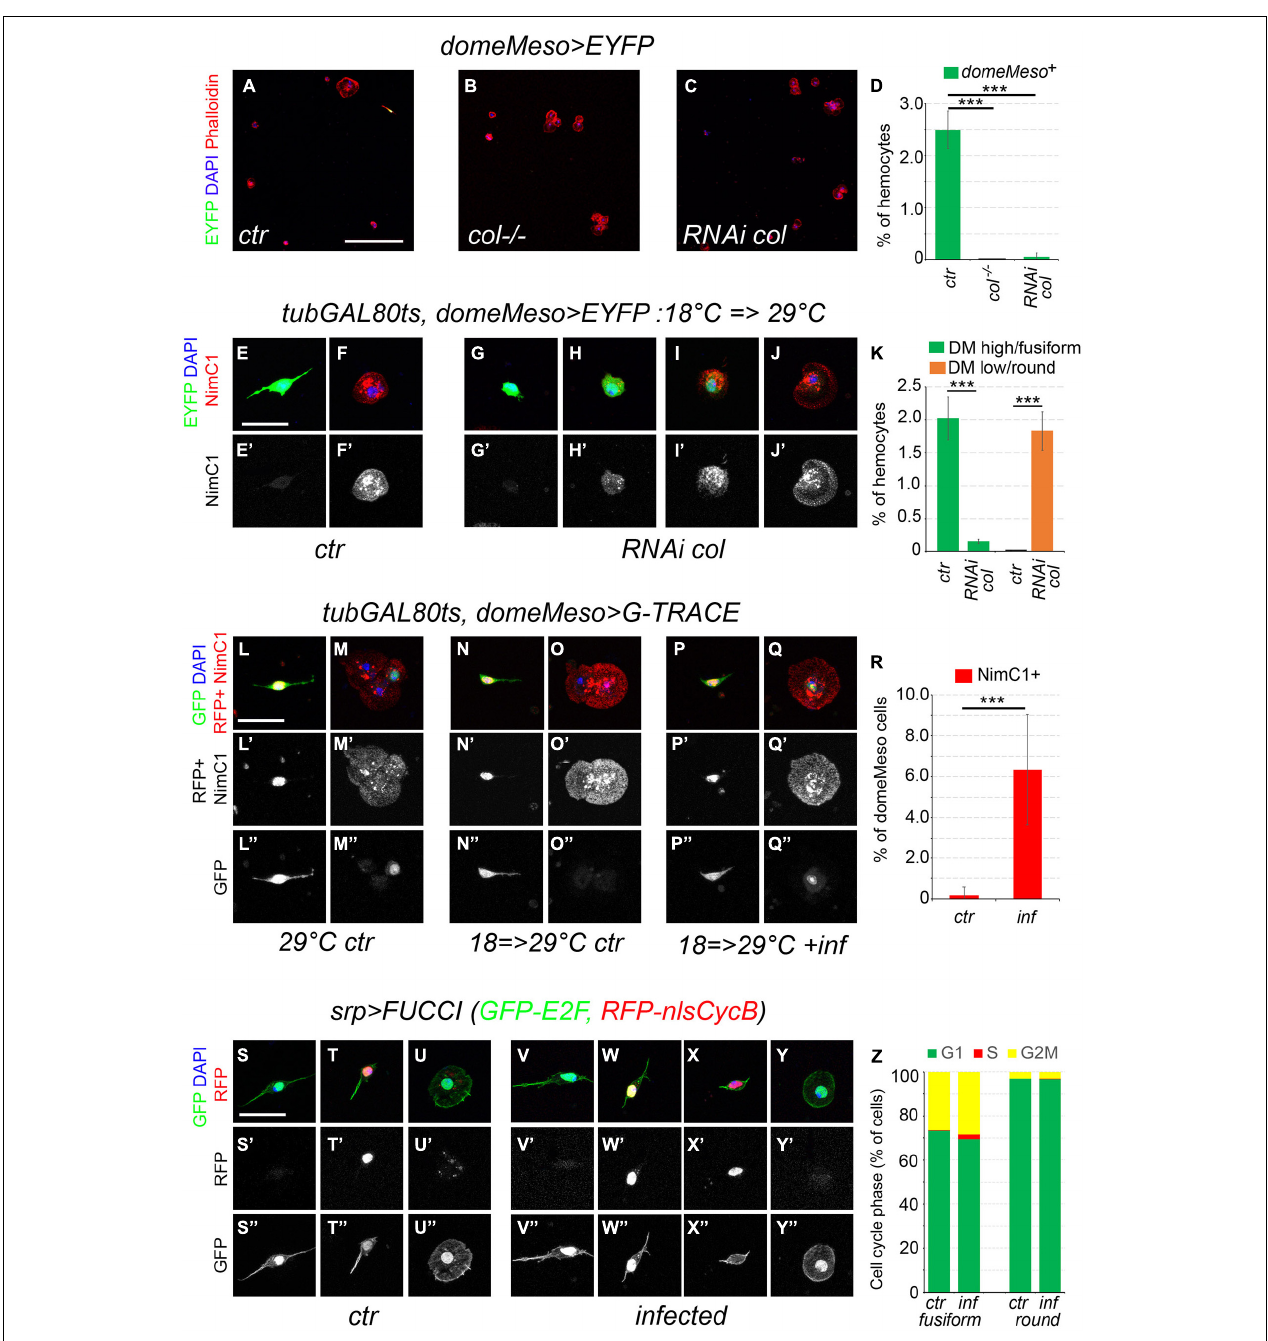
FIGURE 7 | Fusiform cells can differentiate and proliferate. (A–C) Confocal views of blood cells from domeMeso-GAL4, UAS-2xEYFP ( A , ctr ), col − / − , domeMeso-GAL4, UAS-2xEYFP ( B , col − / − ) and domeMeso-GAL4, UAS-2xEYFP, UAS-RNAi col ( C , RNAi col ) adult flies. Blood cells were stained with phalloidin (red) and DAPI (blue). Scale bar 200 µ m. (D) Quantifications of the proportion of domeMeso + hemocytes. Means and standard deviations of at least three independent experiments are presented. A total of 2612, 2350, and 4271 hemocytes were scored in control ( ctr ), col − / − , and RNAi col flies, respectively. *** p < 0.001 (Student’s t -test). (E–J) Blood cells from tub-GAL80ts, domeMeso-GAL4, UAS2x-EYFP adult flies expressing (G–J) or not (E,F) col RNAi only during adulthood. P1/NimC1 expression (red/white in lower panels) was revealed by immunostaining. Nuclei were stained with DAPI (blue). Scale bar: 20 µ m. (K) Quantifications of the proportion of domeMeso high /fusiform hemocytes (green) and domeMeso low /round hemocytes in tub-GAL80ts, domeMeso-GAL4, UAS2x-EYFP adult flies expressing ( RNAi col ) or not ( ctr ) col RNAi during adulthood. Means and standard deviations of at least three independent experiments are presented. A total of 2892 and 4489 hemocytes were scored in ctr and RNAi col flies, respectively. *** p < 0.001 (Student’s t -test). (L–Q) Blood cells from tub-GAL80ts, domeMeso-GAL4, G-TRACE flies raised at permissive temperature (L,M) or switched from restrictive to permissive temperature 24 h after adult emergence (N–Q) . domeMeso live expression is revealed by nuclear RFP (red) and its lineage-traced expression by nuclear GFP (green). P1/NimC1 expression (red)